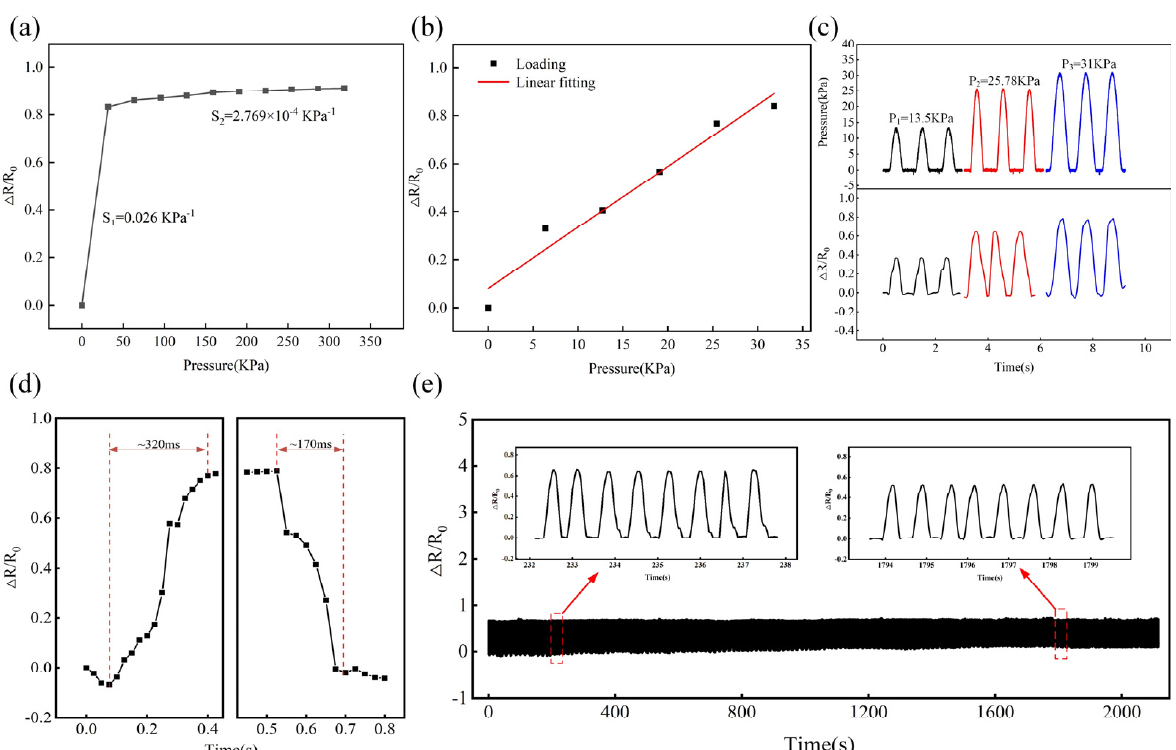
Figure 7. ( a ) Relative resistance change of pressure sensor during loading process; ( b ) high-resolu- tion curve for low-pressure range 0 − 31.83 KPa; ( c ) dynamic response of pressure sensor under load- ing/unloading cycle with different pressure; ( d ) response and recovery time of pressure sensor at loading/unloading pressure of 31 KPa; and ( e ) cyclic stability of pressure sensor under 40% load- ing/unloading cycles.